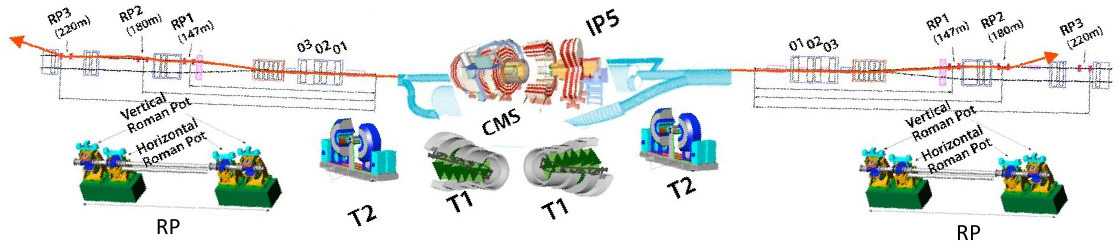
Figure 1. Sketch of the TOTEM and CMS experiments at the LHC